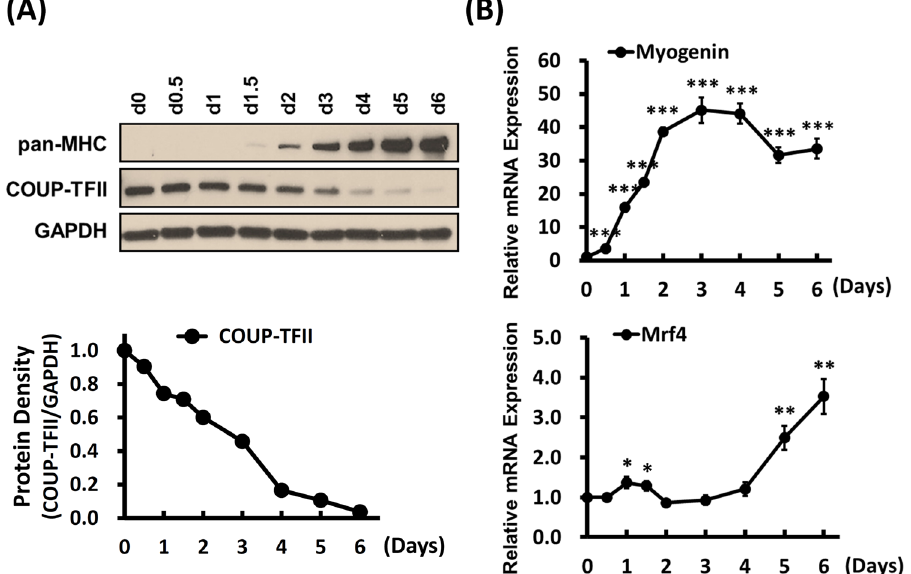
Figure 1. COUP-TFII expression decreases during myogenic differentiation in C2C12 mouse myoblast cells. ( A ) Western blot analyses of COUP-TFII protein expression during myogenic differentiation in C2C12 cells. Relative COUP-TFII protein level was quantified by band density and normalized to GAPDH as shown in bottom panel. ( B ) Quantitative RT-PCR examination of Myogenin (MRF in early differentiation stage) and MRF4 (MRF in terminal differentiated myotube) mRNA expression pattern C2C12 cells were placed in the differentiation medium (DM, 2% horse serum) and incubated for the indicated time points. Day 0, serum withdraws in confluent culture cells as the initiation of myogenesis; medium was changed every other day. Data are shown as mean ± SEM. One-way ANOVA followed by Bonferroni’s Multiple Comparison Test; * p < 0.05, ** p < 0.01, *** p < 0.001, compared to day